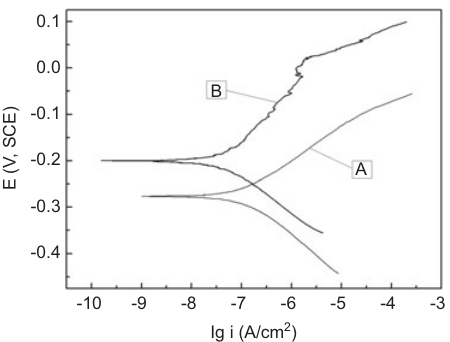
Figure 5 Polarization curves for TiC/316L composites in 3.5 wt. %